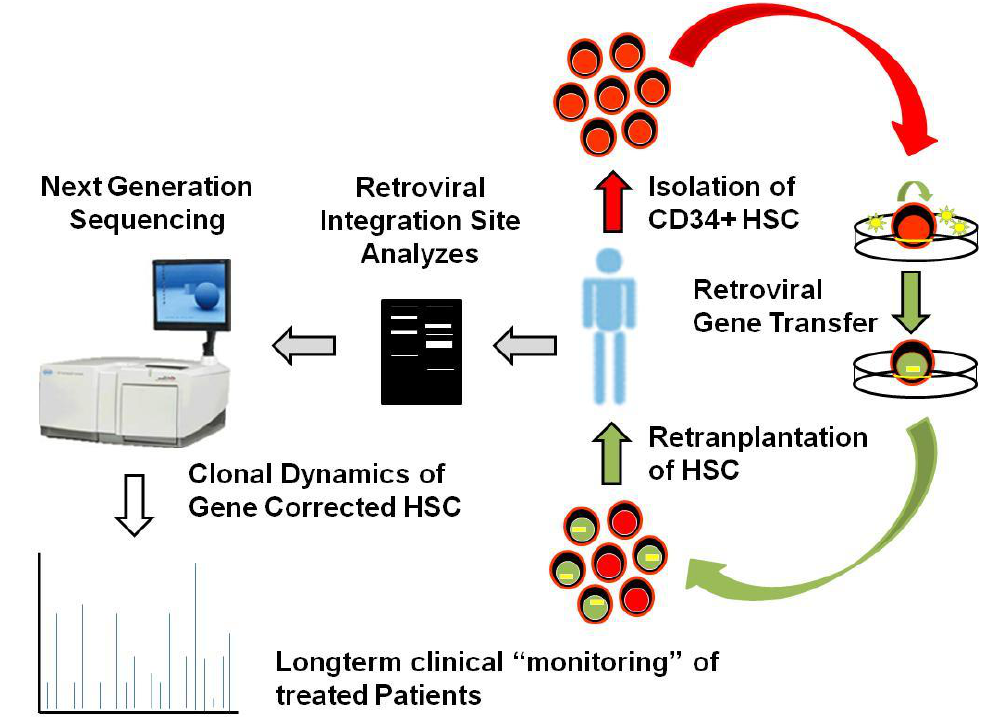
Figure 2. Analyzing clonal dynamics and insertional induced side effects by retroviral integration site analyzes and next generation sequencing